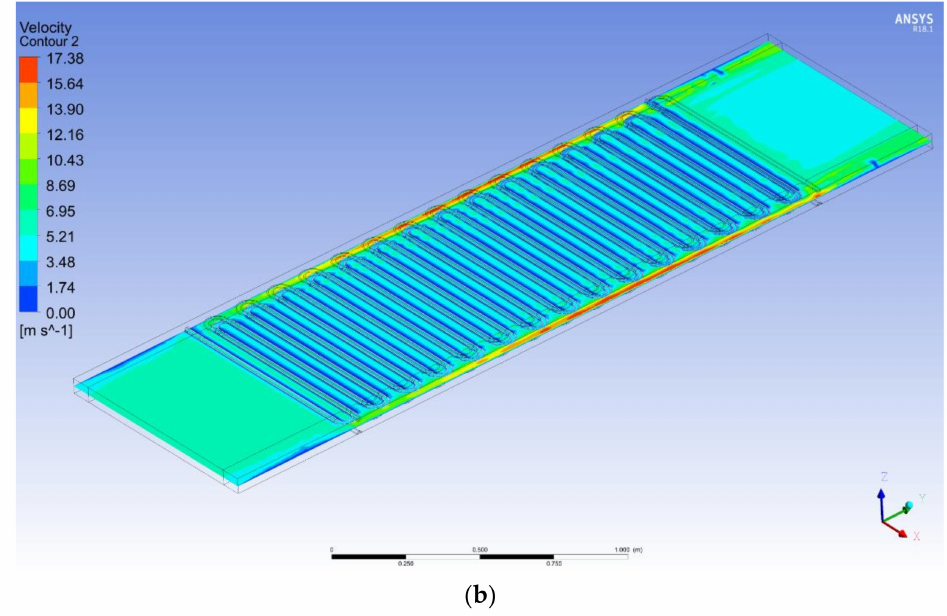
Figure 6. CFD results at the centerline of the scaled SCO 2 heat exchanger: ( a ) temperature and ( b ) velocity